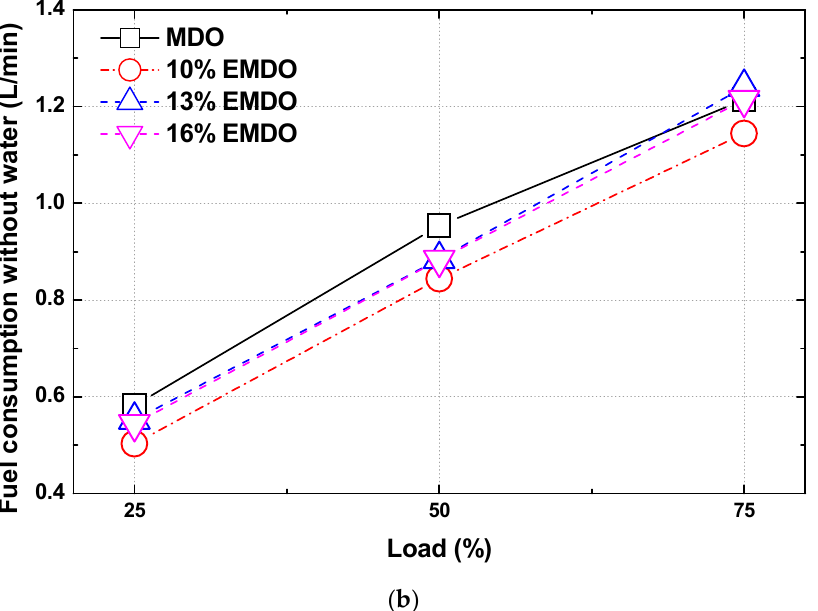
Figure 8. Fuel consumption of MDO and EMDO fuel according to emulsified fuel ratio: ( a ) With water; ( b ) Without water.